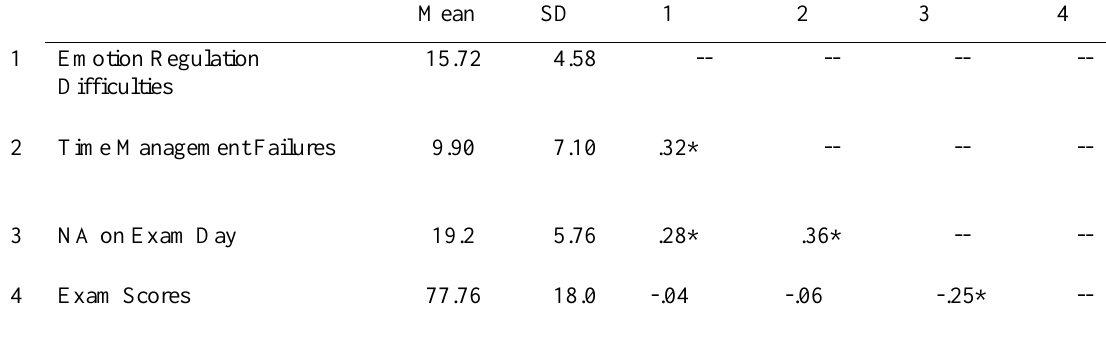
Means, Standard Deviations, and Correlations